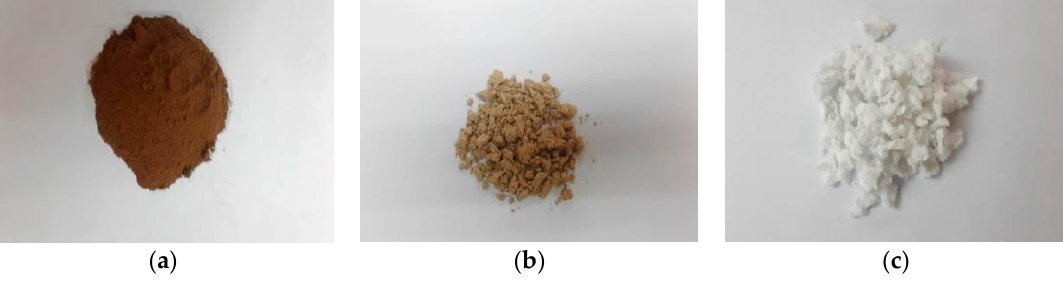
Figure 1. Photographs of ( a ) raw TLWF; ( b ) alkaline-treated TLWF; and ( c ) bleached TLWF.